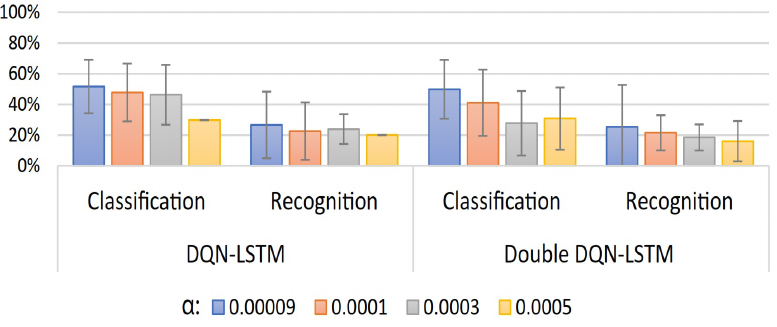
Figure 9. User-specific HGR model classification and recognition accuracy results for 20 users with different values of learning rate ( α ) for both DQN and Double-DQN with